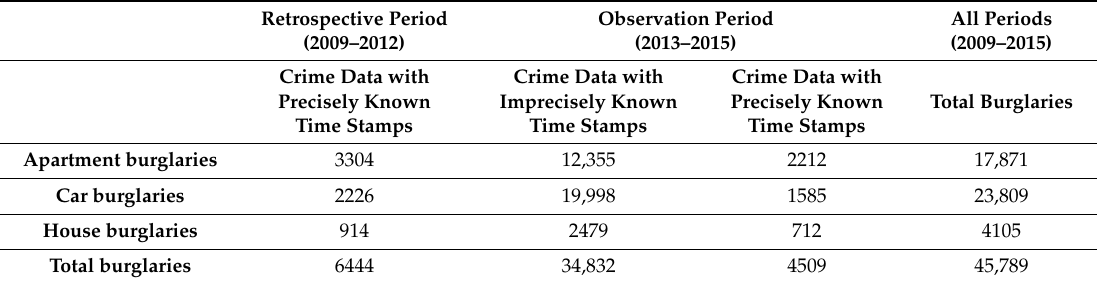
Table 1. Number of crimes with imprecisely and precisely known time stamps for three di ff erent crime types and two di ff erent non-overlapping time periods (2009–2012 and 2013–2015) applied to eight temporal approximation